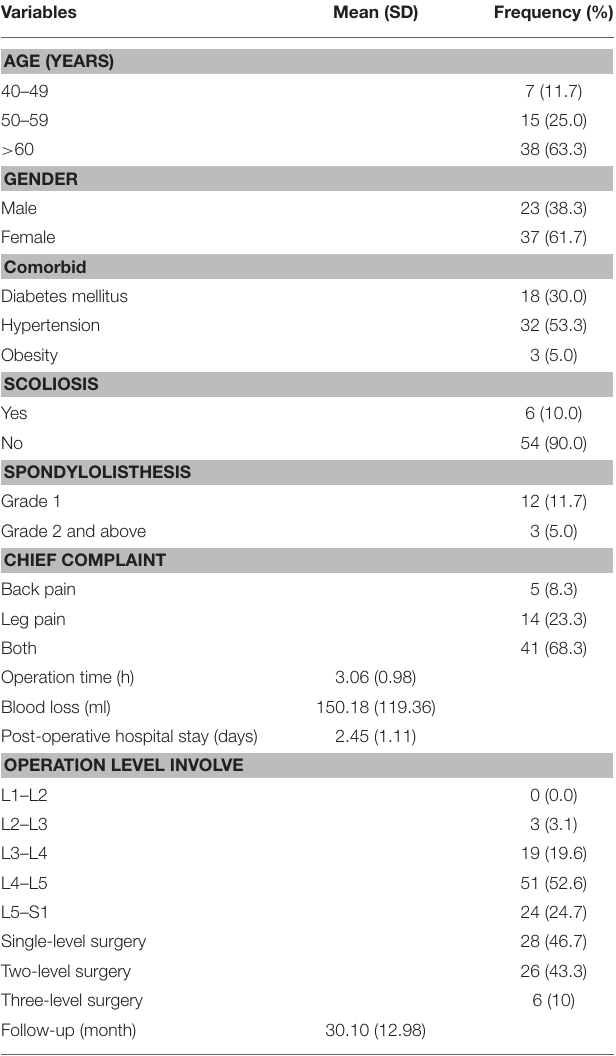
TABLE 1 | Biodemographic data of patients who underwent endoscopic lumbar stenosis